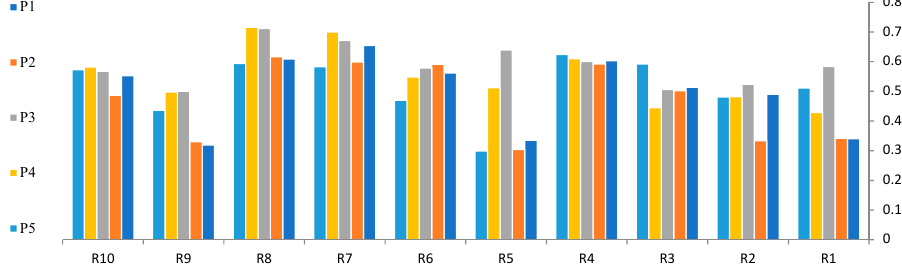
Figure 5. The rating results of different risks in 5 projects. Source: Authors’ elaboration.